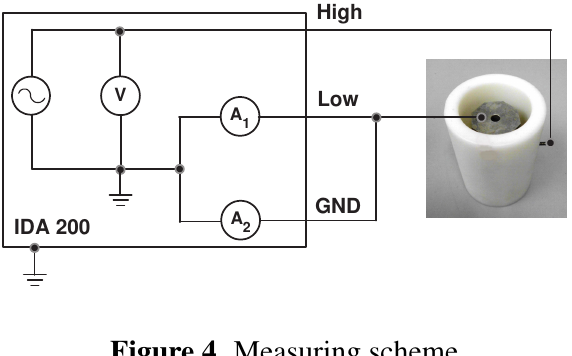
Figure 4. Measuring scheme.